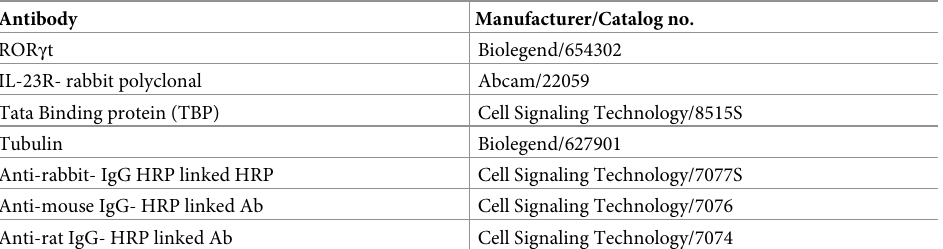
Table 3. Antibodies used for Western